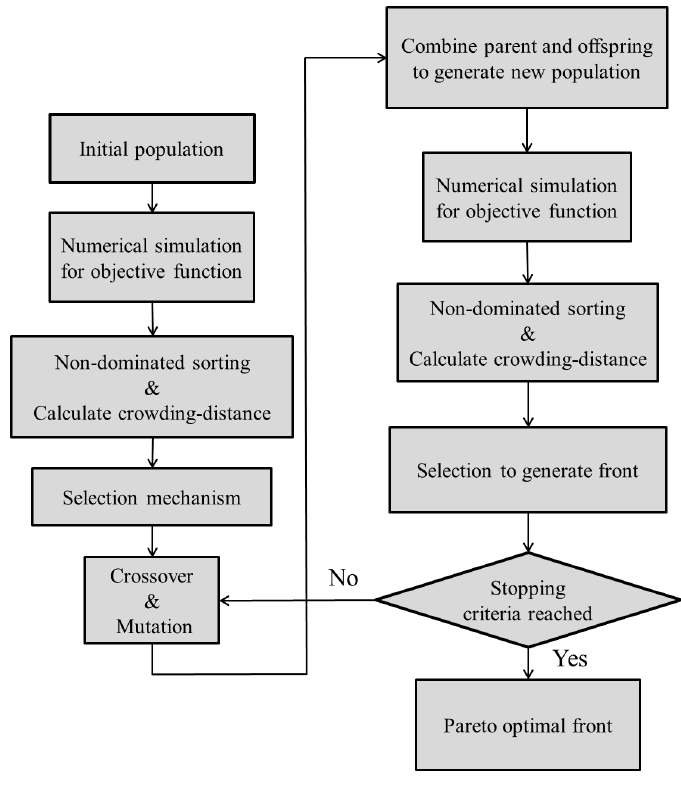
Figure 7. The flow chart of the NSGA-II method.